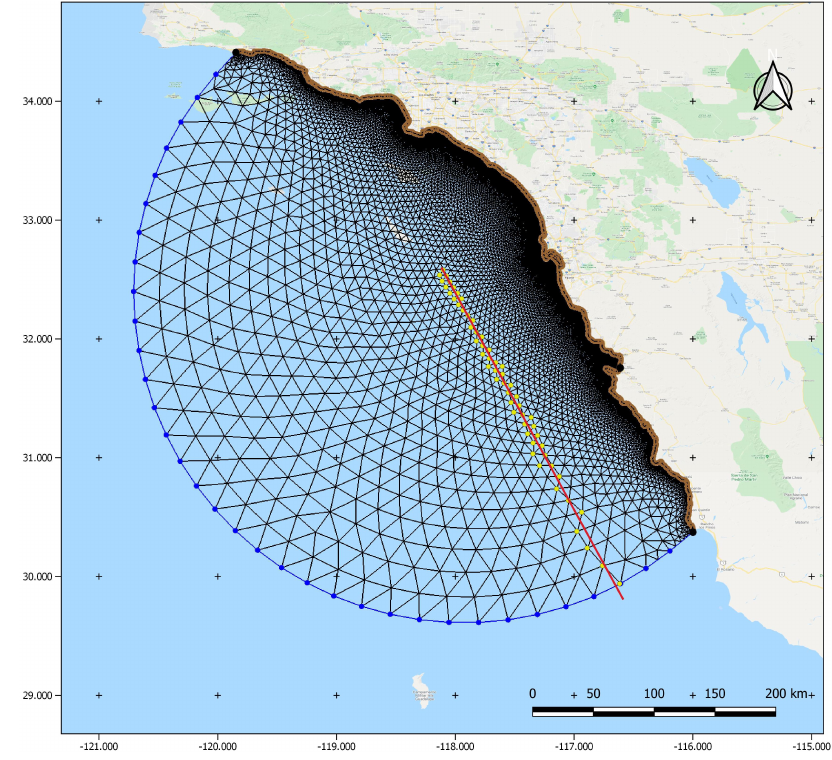
Figure 6. Location of the “virtual buoys” within the computational